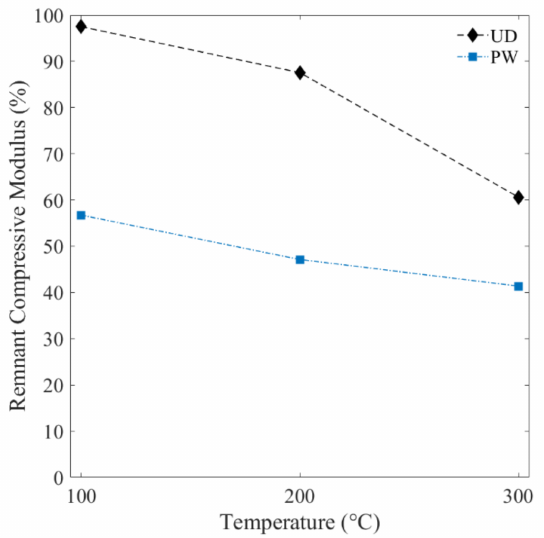
Figure 5. Remnant compressive modulus (expressed as a percentage of modulus at room temperature) of PW and UD PT 30